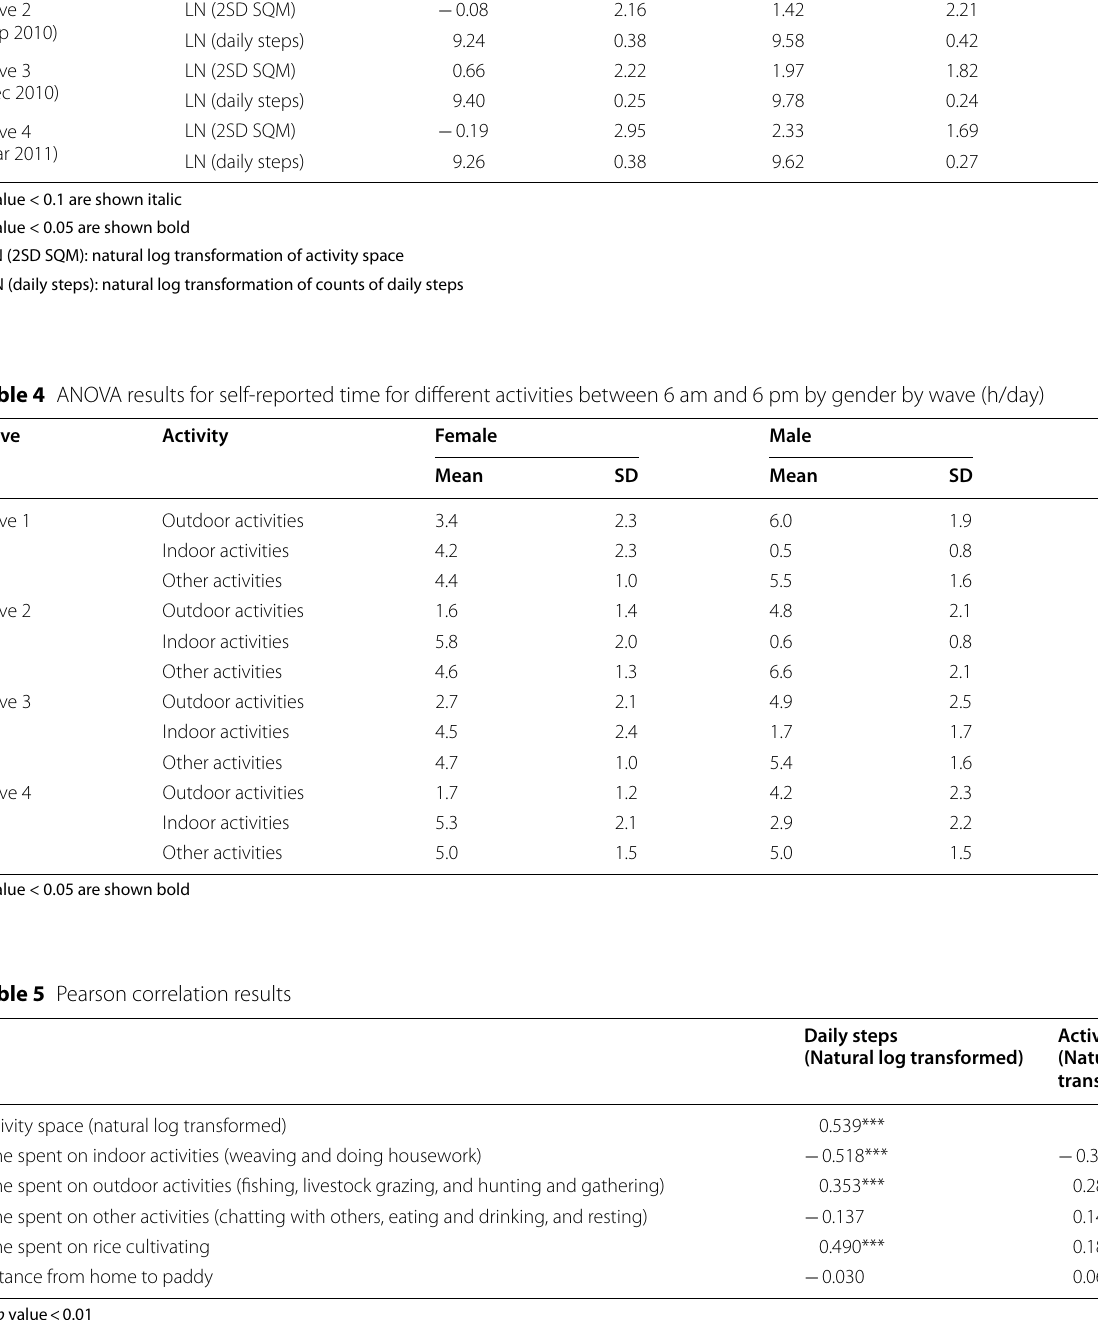
Table 3 ANOVA results of activity space and total steps by gender and by wave